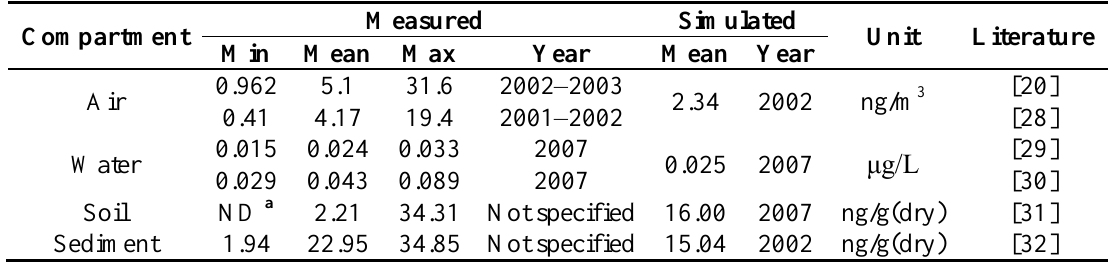
Table 2. Comparison of the measured and the simulated concentrations of BaP in Nanjing. Measured Compartment